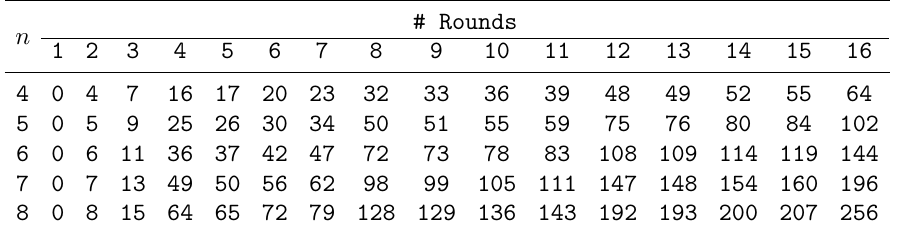
Table 8: The minimum number of active S-boxes for SPN structures with ShiftRows and near-MDS matrices of order